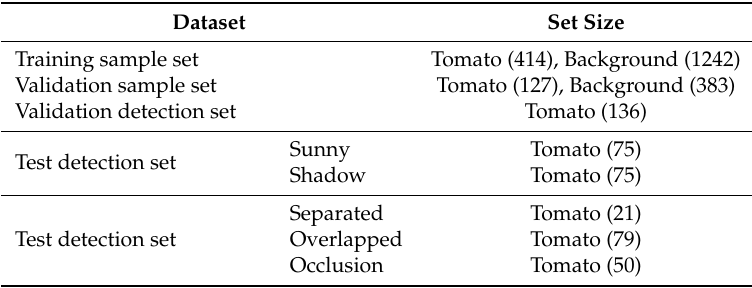
Table 1. The datasets for the